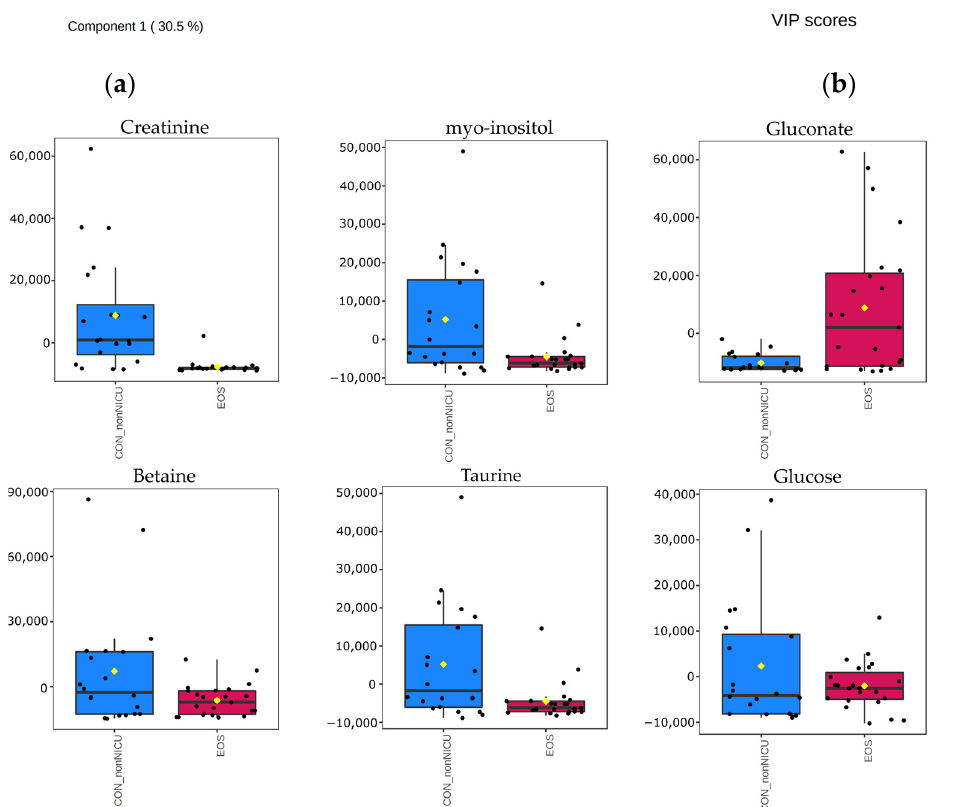
Figure 2. Spectral regions of unassigned chemical shifts mostly present on 1 H NMR spectra of NICU samples (blue spectrum) and healthy non-NICU preterms (black spectrum).